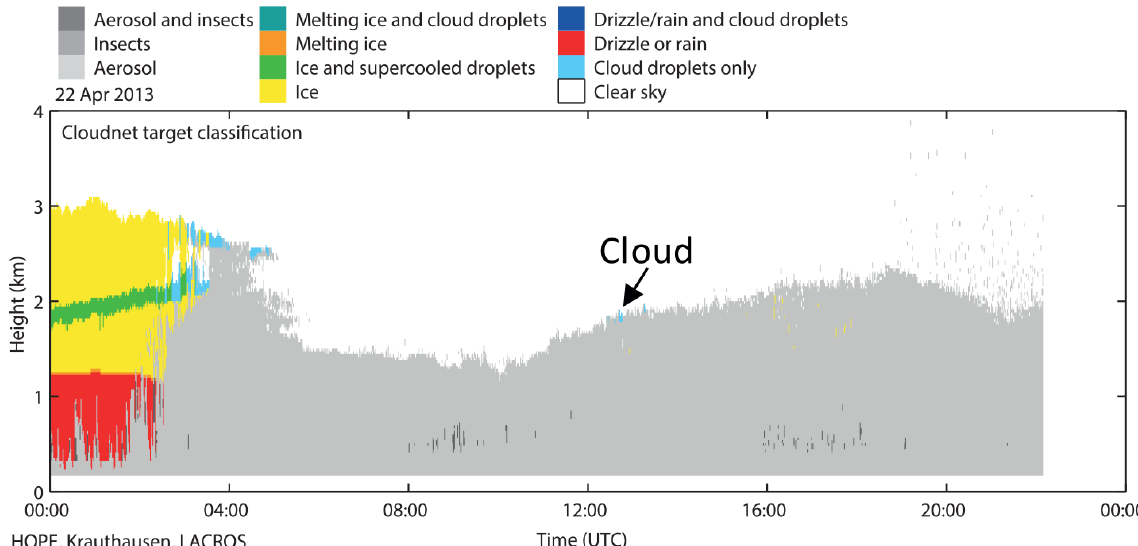
Figure 9. Cloudnet target categorization for 22 April